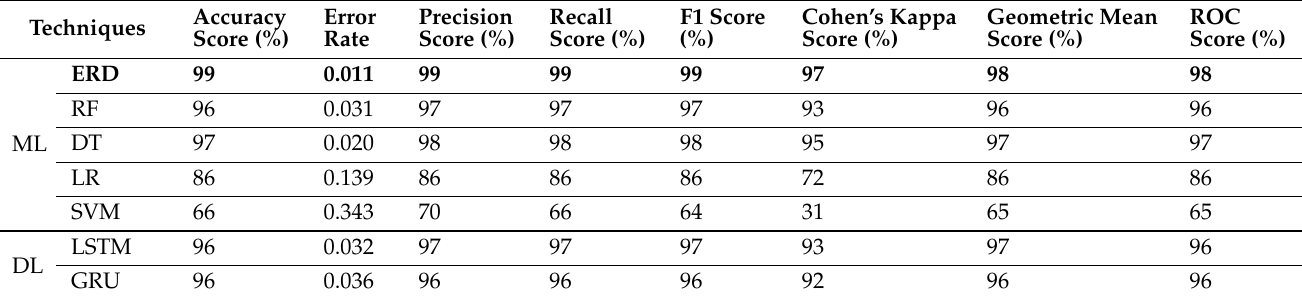
Table 6. Comparative performance analysis of the applied machine learning and deep learning techniques on unseen test